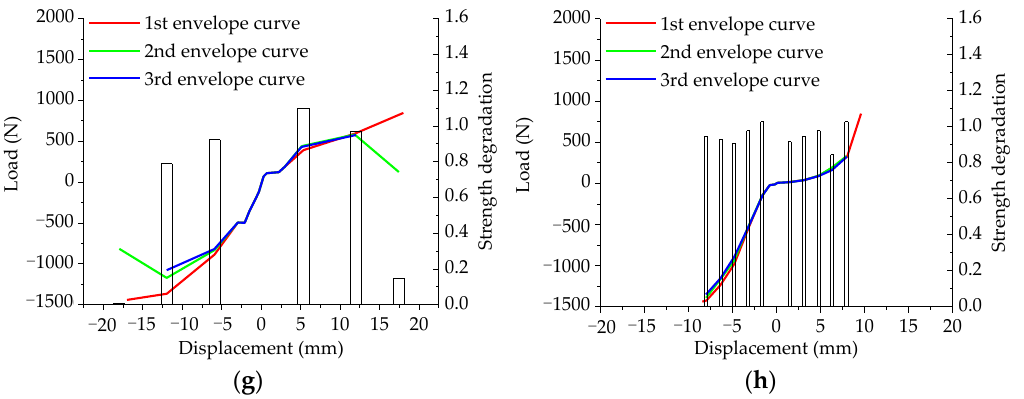
Figure 6. Envelope curves and strength degradation of the test specimens: ( a ) CSN, ( b ) CSS, ( c ) CBN, ( d ) CBS, ( e ) PSN, ( f ) PSS, ( g ) PBN, ( h ) PSS.